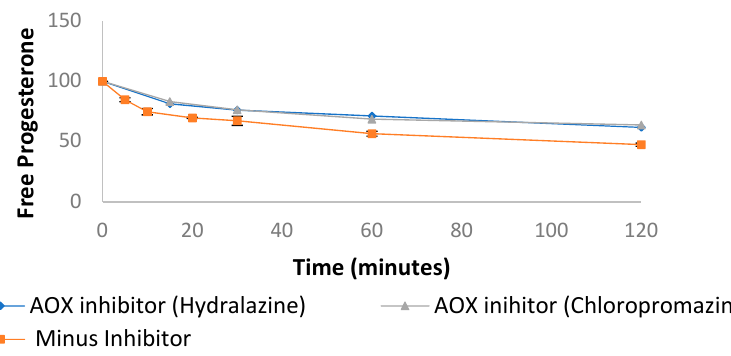
Figure A3 . Concentration (expressed as percent of initial value) of progesterone as function of incu- bation time with human liver cytosol in absence of NADPH with the addition of AKR enzyme in- hibitors, as indicated.